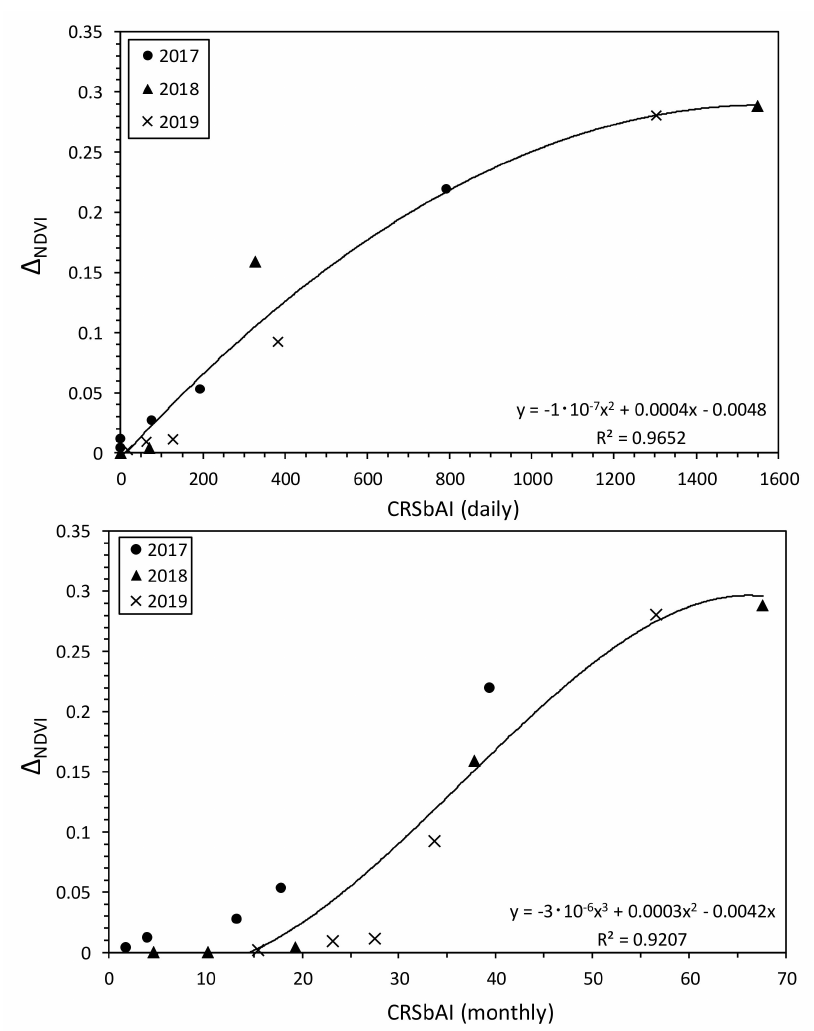
Figure 8. Relationships of CRSbAI (daily) and CRSbAI (monthly) with ∆ NDVI in Bayan-Unjuul from 2017 to